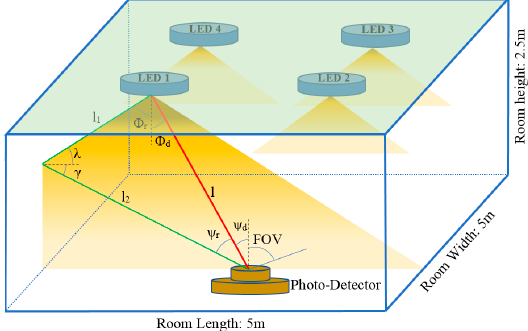
Figure 1. Typical room and channel model.